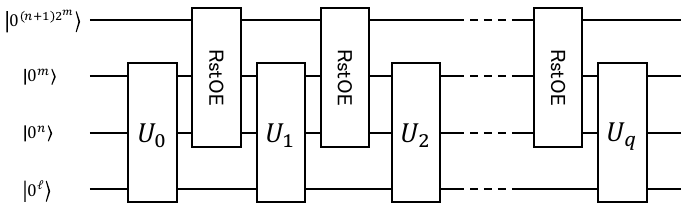
Figure 1: A quantum circuit that illustrates an adversary A that runs relative to RstOE . The register | 0 ( n +1)2 m i at the top corresponds to the oracle’s state. The second and third registers ( | 0 m i and | 0 n i ) are used to send queries and receive answers, respectively. The register | 0 ‘ i at the bottom corresponds to A ’s private working space for offline